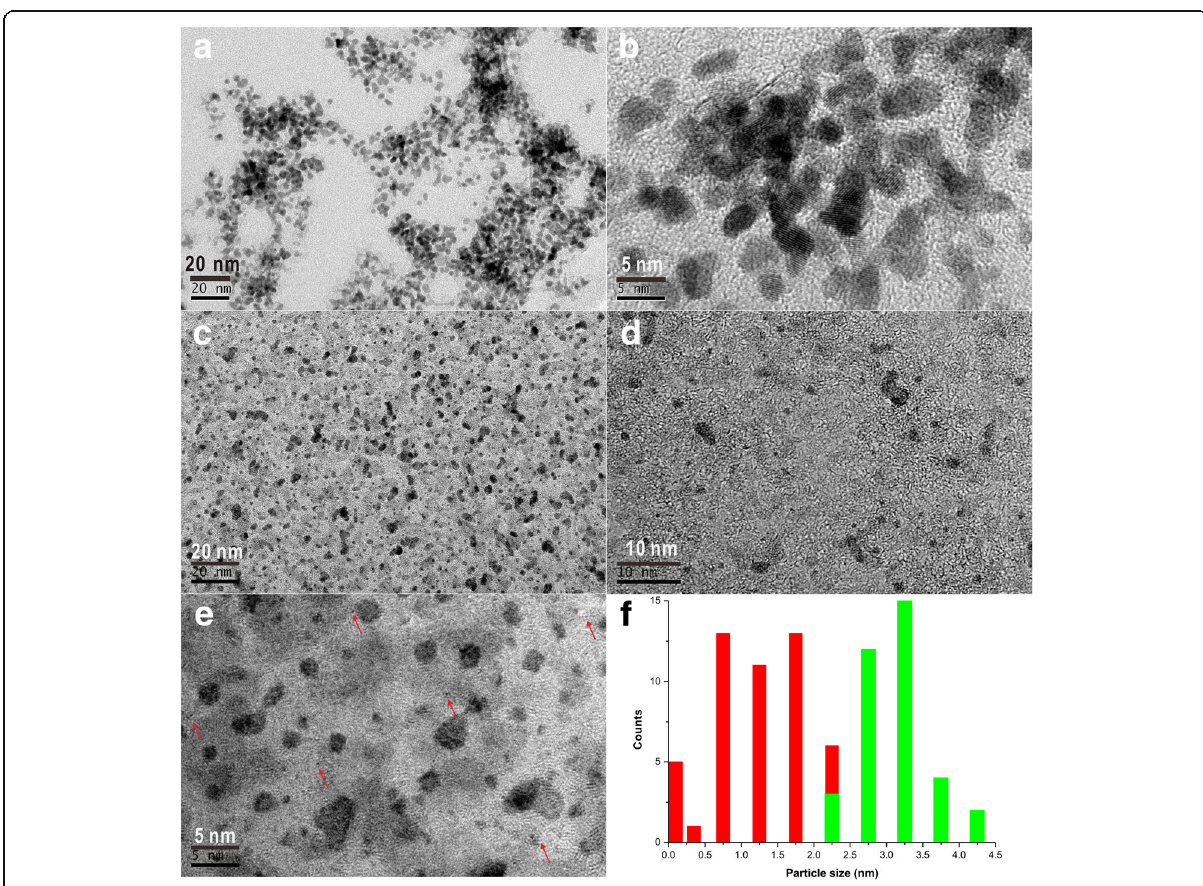
Fig. 1 HRTEM images of a , b Pt nanoparticles prepared by the reduction by NaBH 4 without acoustic levitation (0.5 g/L), c – e Pt clusters prepared by the acoustic levitation (0.5 g/L), and f particle size distributions for the above two Pt colloids (green for NaBH 4 reduction, red for acoustic